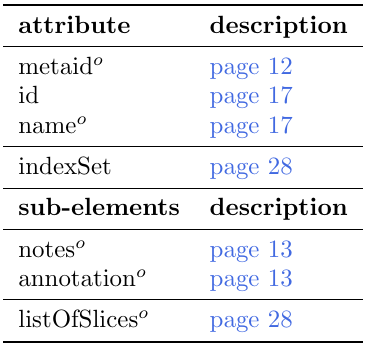
Table 2.7: Attributes and nested elements for dataSource. o denotes optional elements and attributes.